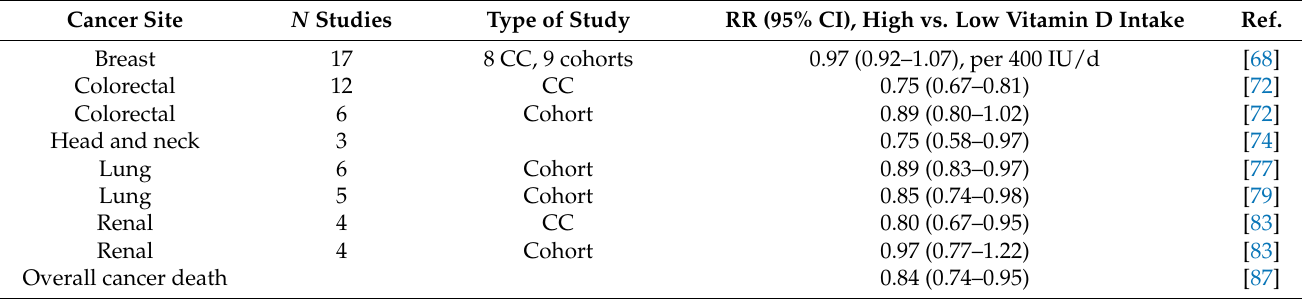
Table 6. Meta-analyses of observational studies of the risk of incidence of individual cancer sites related to vitamin D intake.